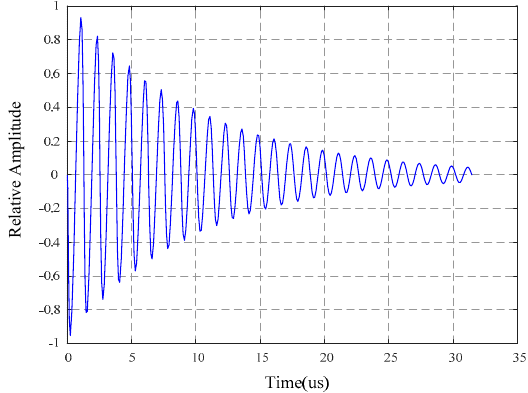
Figure 2. Typical shape of a ring-down response of a magnetoelastic sensor after the excitation field is removed.